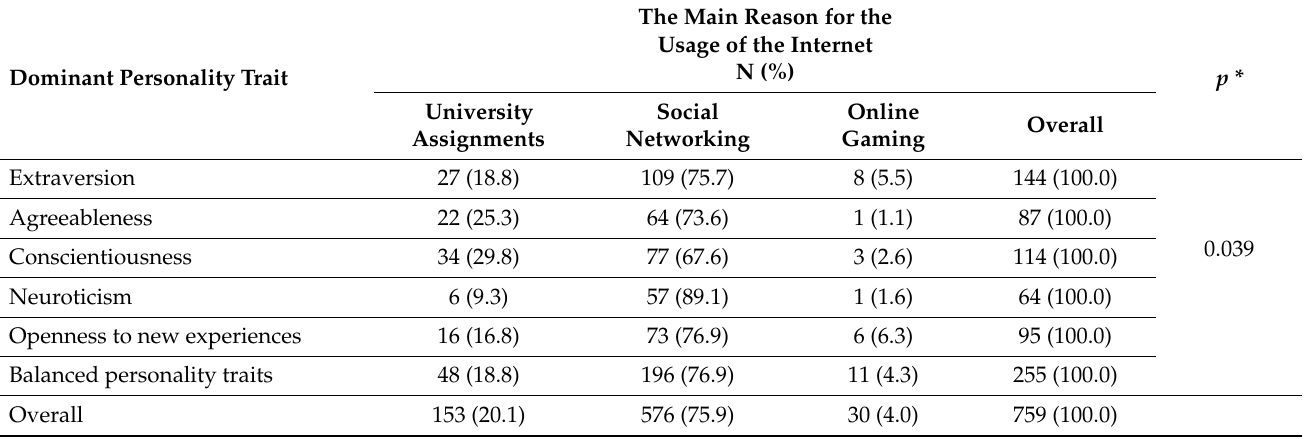
Table 4. Participants with IA according to the main reason for the usage of the Internet and dominant personality